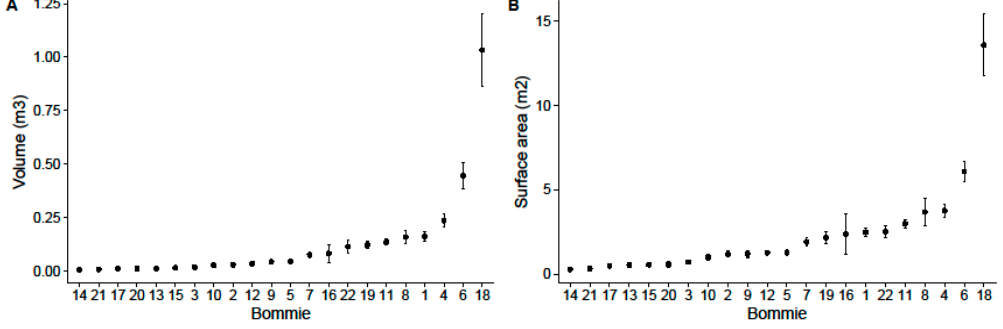
Figure 3. Mean ( A ) volume and ( B ) surface area ± 95% CI for the bommies used to compare observer effects. Bommies sorted according to mean volume and surface area, respectively.